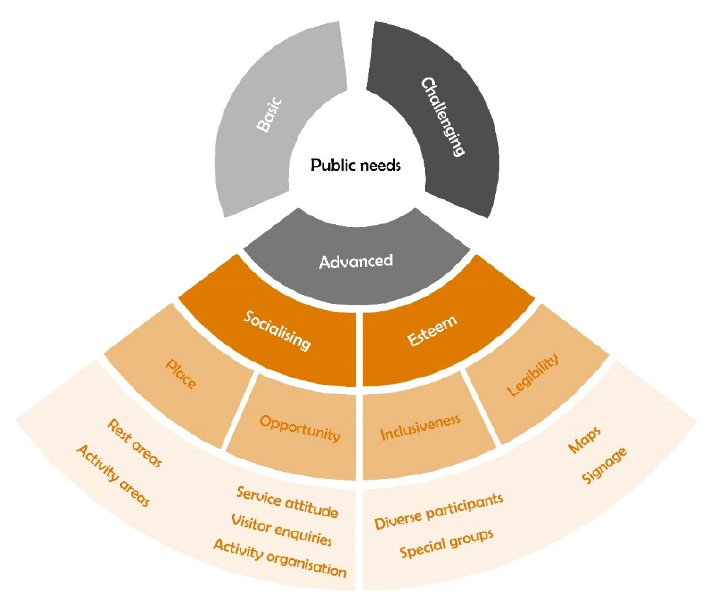
Figure 4. Measuring framework for advanced needs (by author, 2022).